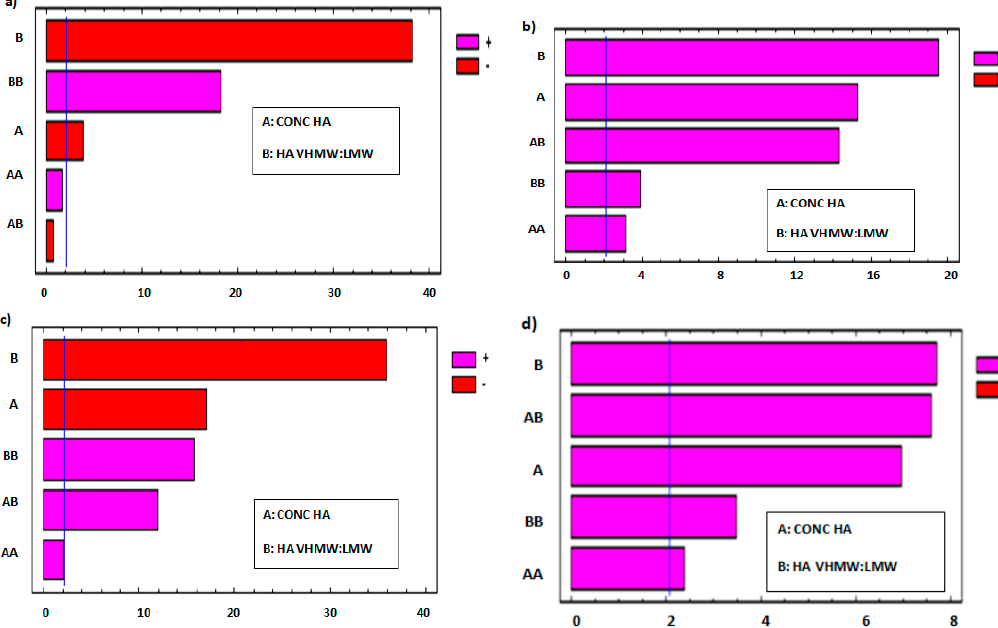
Figure 3. Standardized Pareto chart of the effect of each factor and that of their interactions on each response variable of the full factorial design: ( a ) frequency at cross over, ( b ) viscosity at cross over, ( c ) tan δ at 2.5 Hz, ( d ) dynamic viscosity in rest condition (0.01 s − 1 shear rate). A = HA concentration; B = VHMW:LMV HA ratio; AA, BB, AB: interaction terms [25].